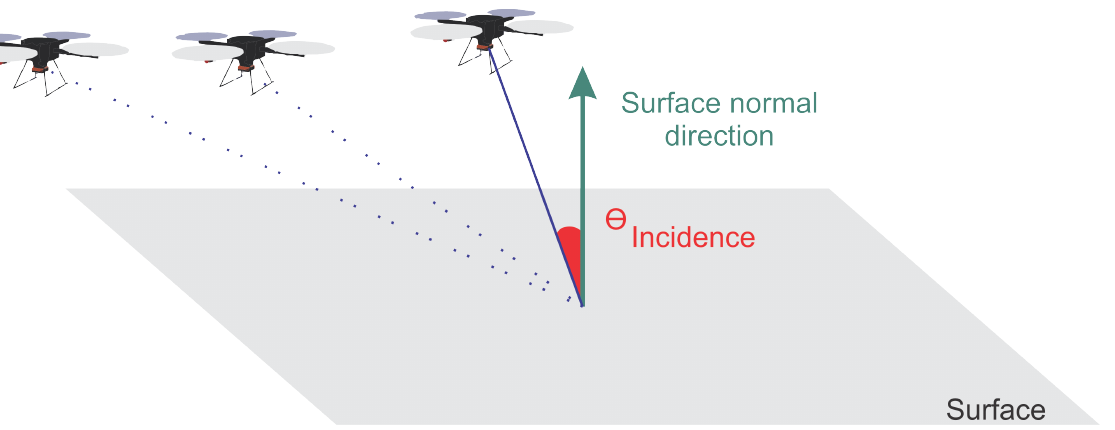
Figure 6. Intersection and incidence